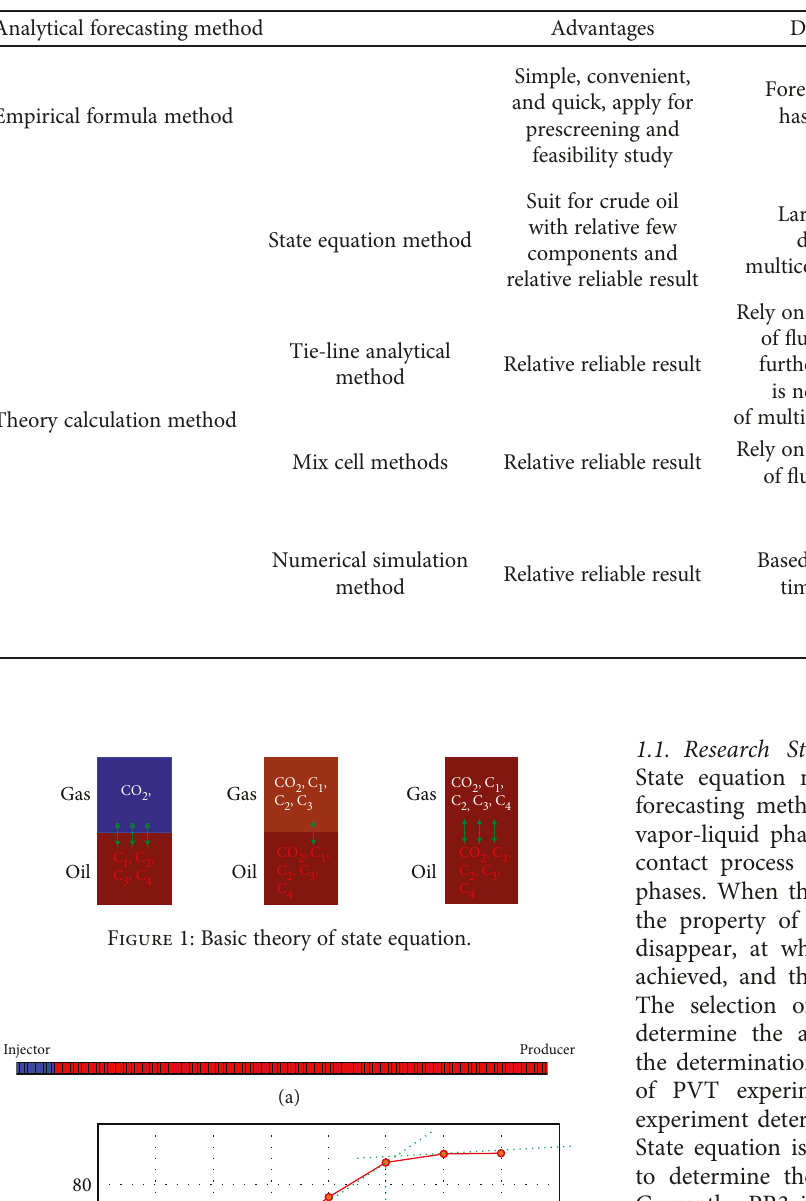
Table 1: Current MMP forecasting methods [5 – 8].